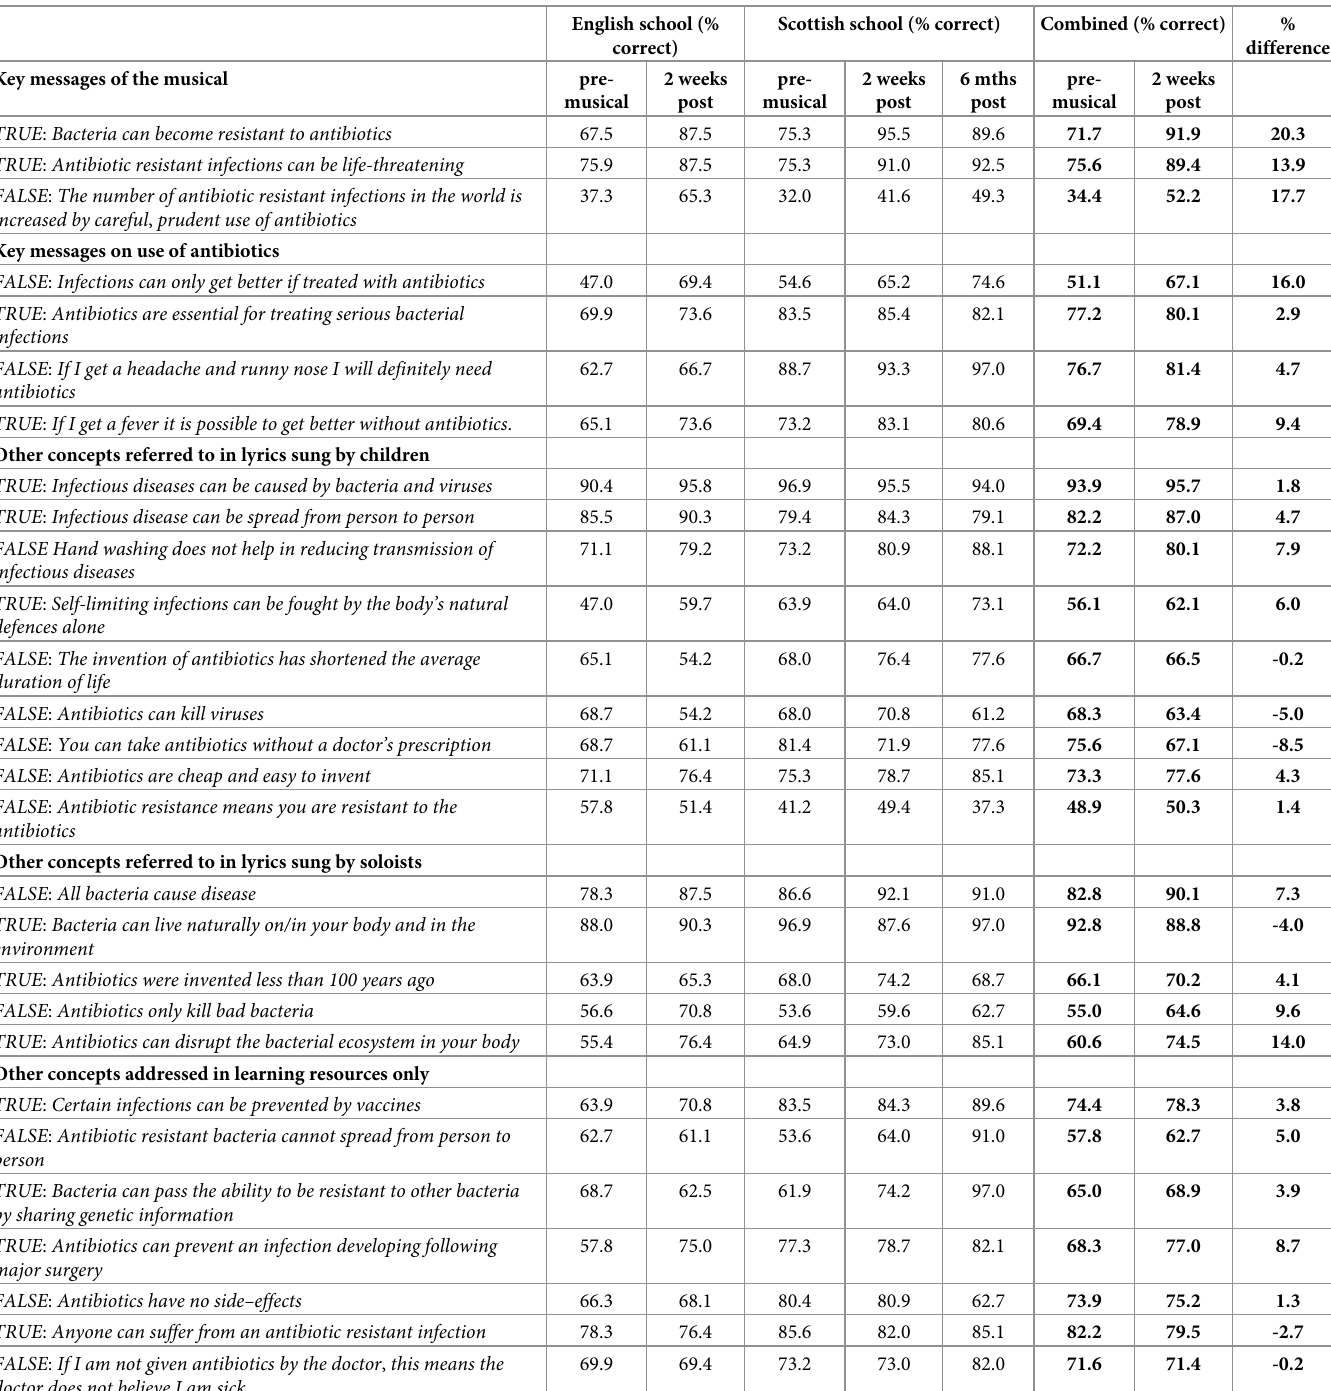
Table 1. True/false questionnaire responses from participating children pre-musical and post-musical.